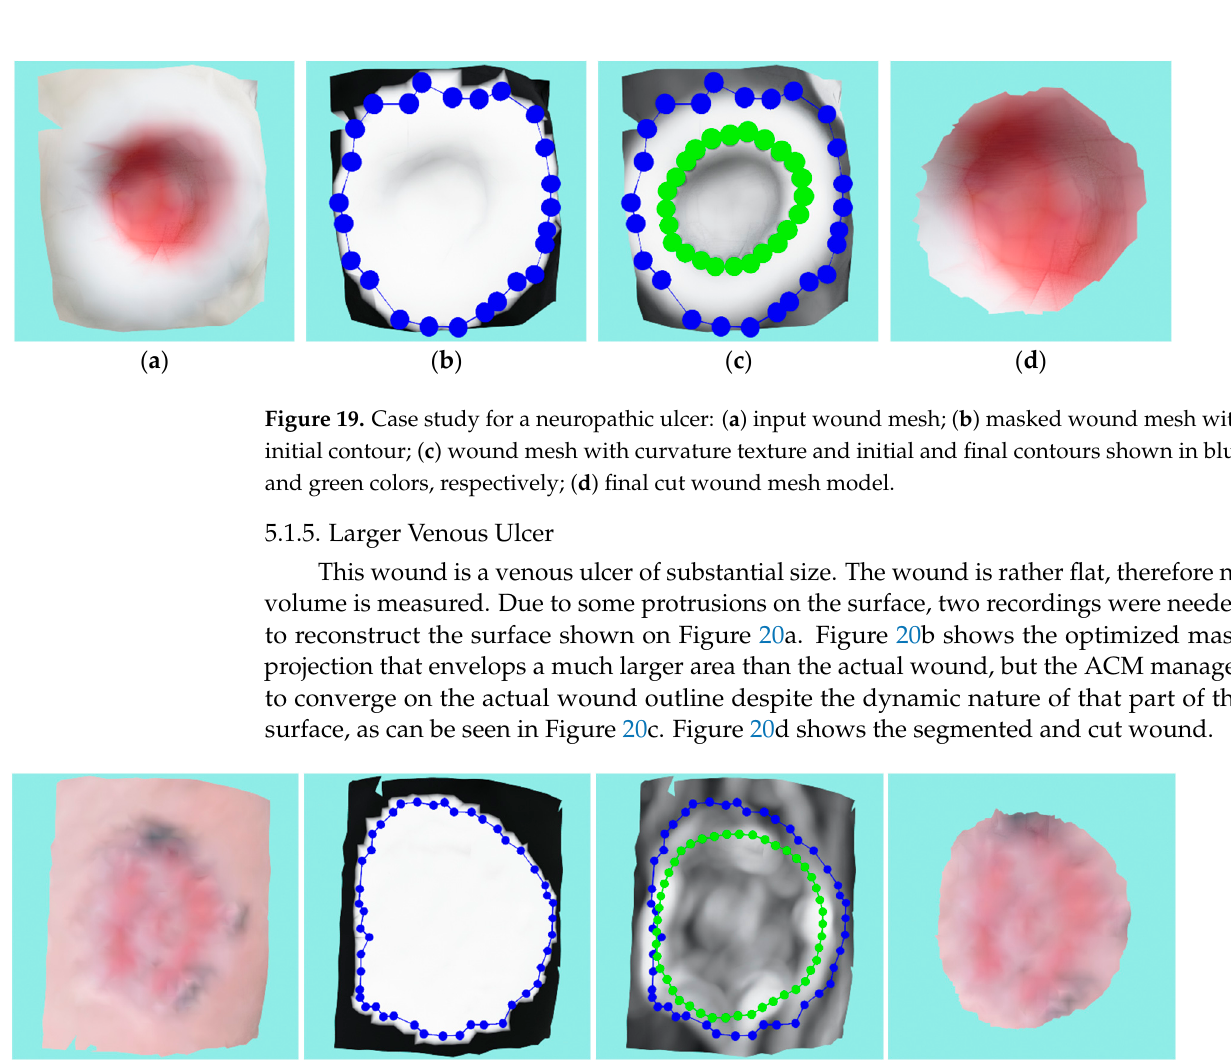
( d ) Figure 18. Case study for stage 4 pressure ulcer: (a) input wound mesh; ( b ) masked wound mesh with initial contour; ( c ) wound mesh with curvature texture and initial and fi nal contours shown in blue and green colors, respectively; ( d ) fi nal cut wound mesh model. The wound perimeter was measured to be 351.53 mm, the area 7689.11 mm 2 , and the volume 109,839.24 mm 3 . The results, when compared to GT, give a percentage error of 4.96% for the perimeter, 8.02% for the area, and 8.94% for the volume. 5.1.4. Neuropathic Ulcer This wound is a neuropathic ulcer of comparatively smaller size compared with the